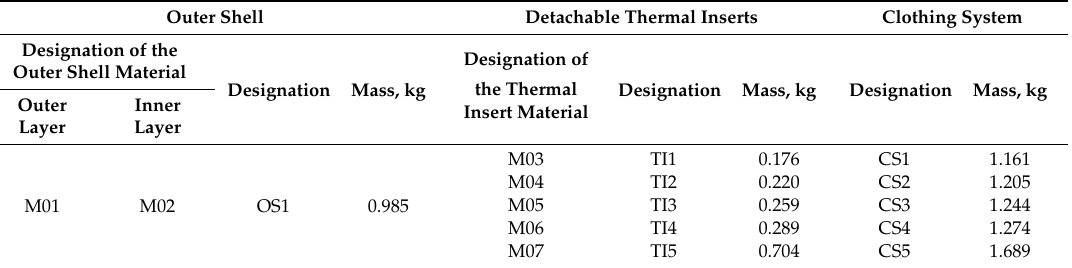
Table 2. Summary of designations and masses of outer shells, detachable thermal inserts, and clothing